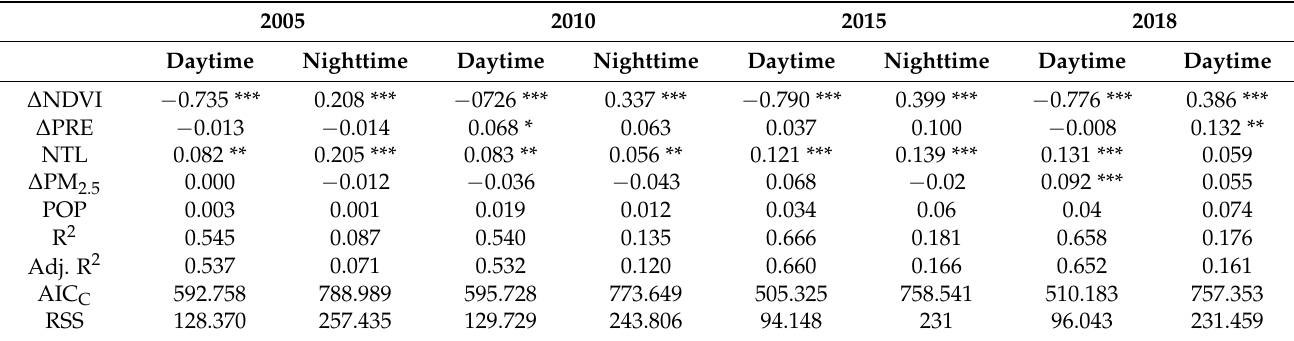
Table 2. Results of the ordinary least squares regression model applied to SUHI intensity and drivers in 2005, 2010, 2015, and